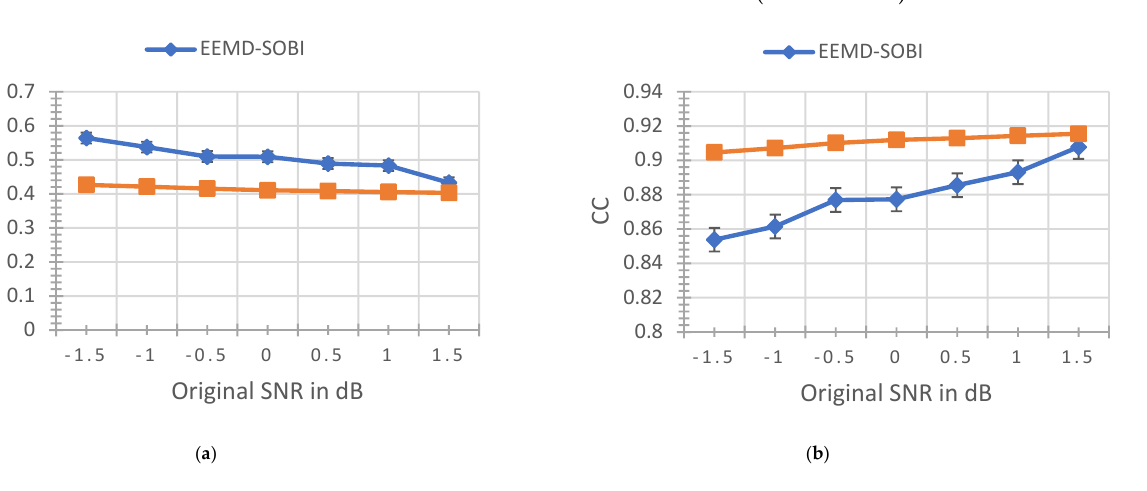
Figure 5. For simulated signals with different signal-to-noise ratios, the statistical results of CC and RMSE of denoising effects of different algorithms. ( a ) Four methods of RRMSE value statistics. ( b ) Four methods of CC value statistics.